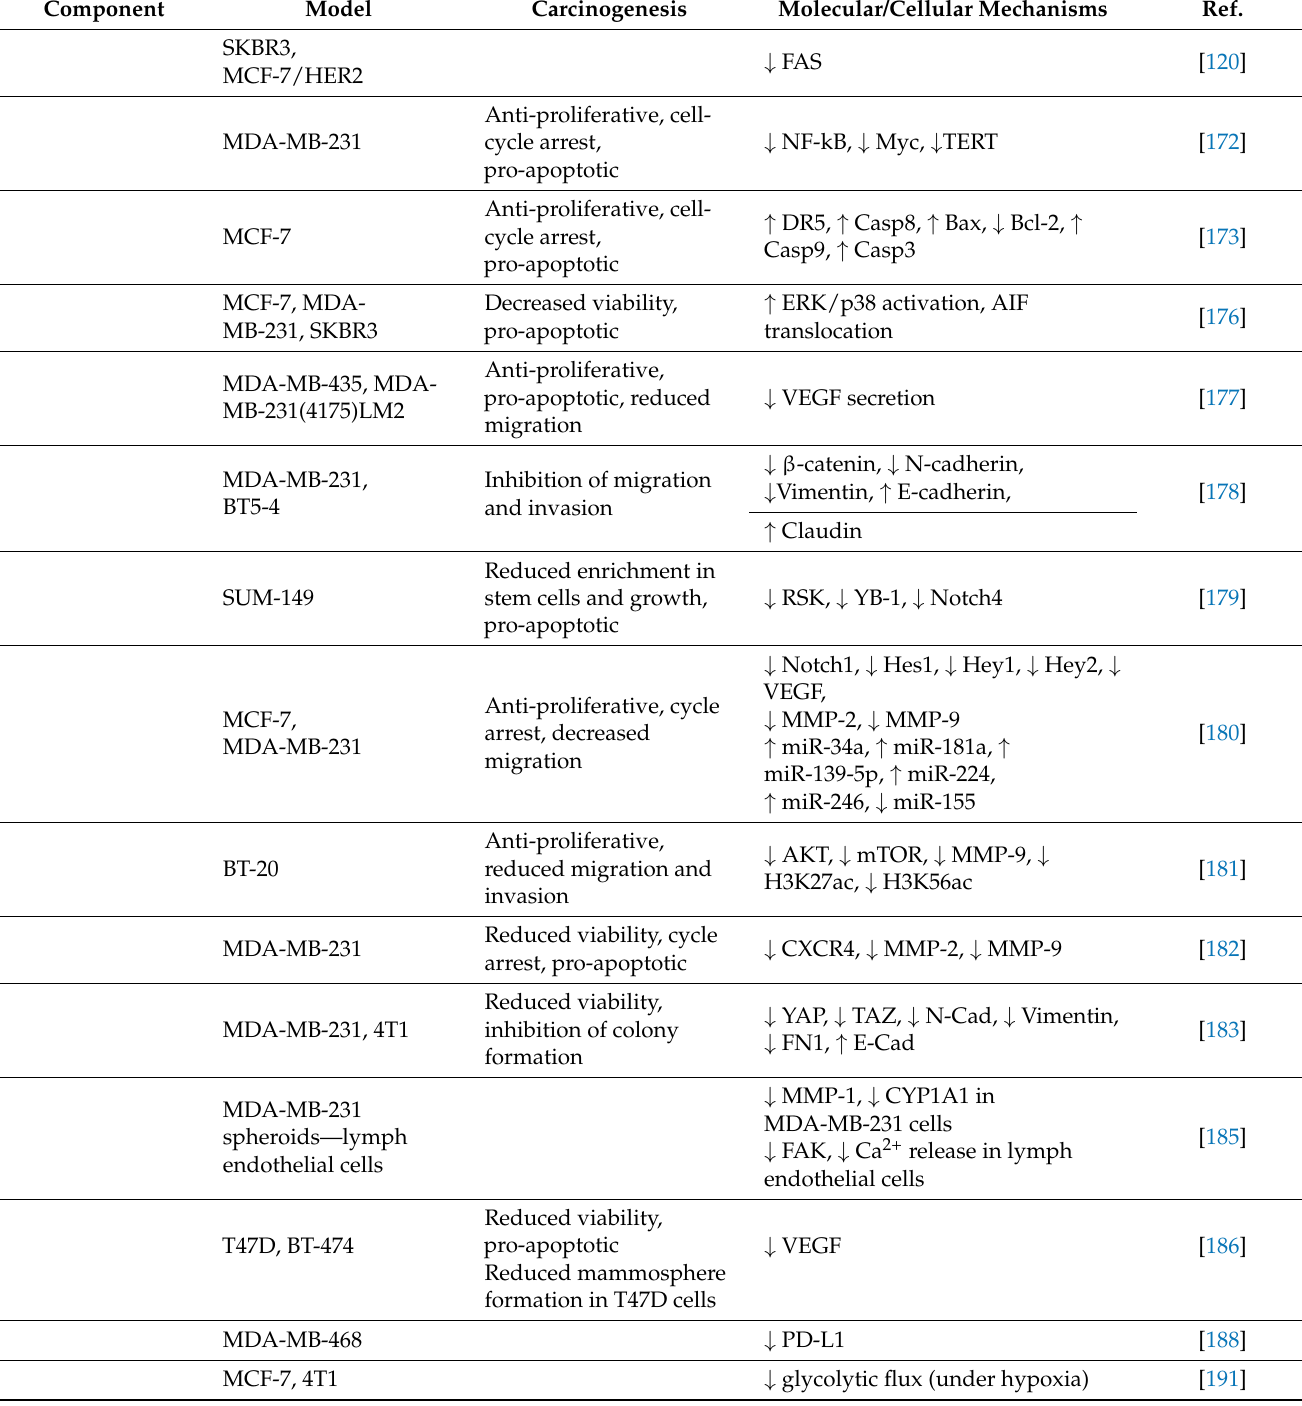
Molecular/Cellular